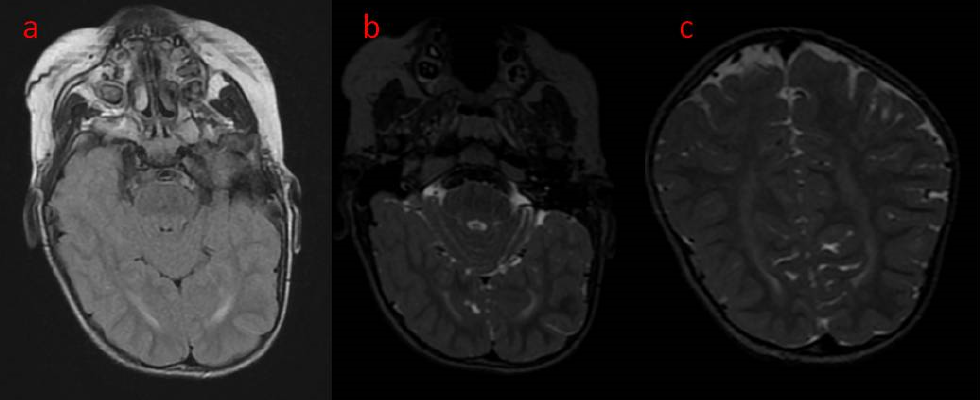
Figure 2. ( a – c ) Brain MRI, axial ( a ) T2 FLAIR ( b ) T2, coronal (T2) unfinished myelinisation of white matter surrounding occipital horns